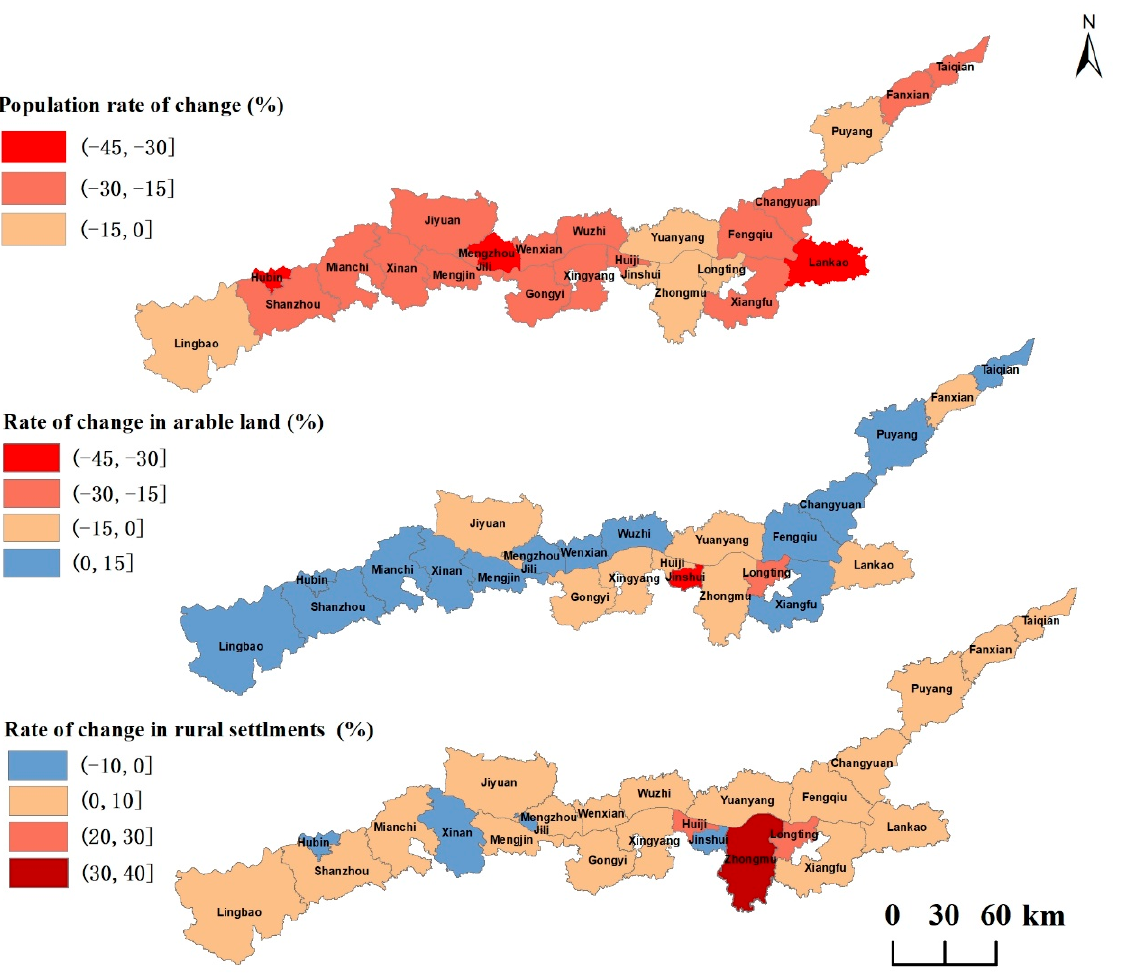
Figure 4. Changes of permanent rural population in the Yellow River Basin (Henan section) during 2009–2018.